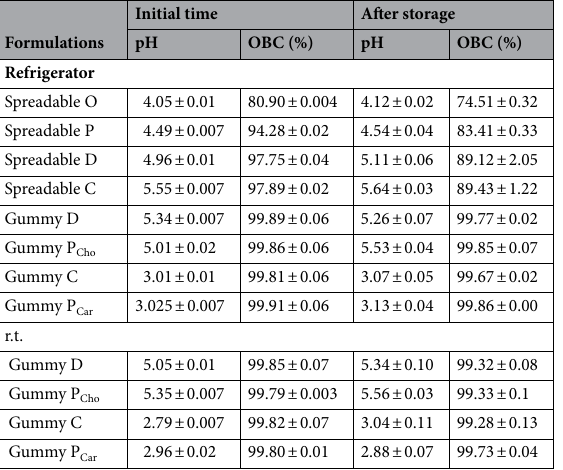
Table 5. The oil binding capacity (OBC) and pH of the functional spreadable oleogels and healthy nutritional gummy formulations. Values represent the means ±